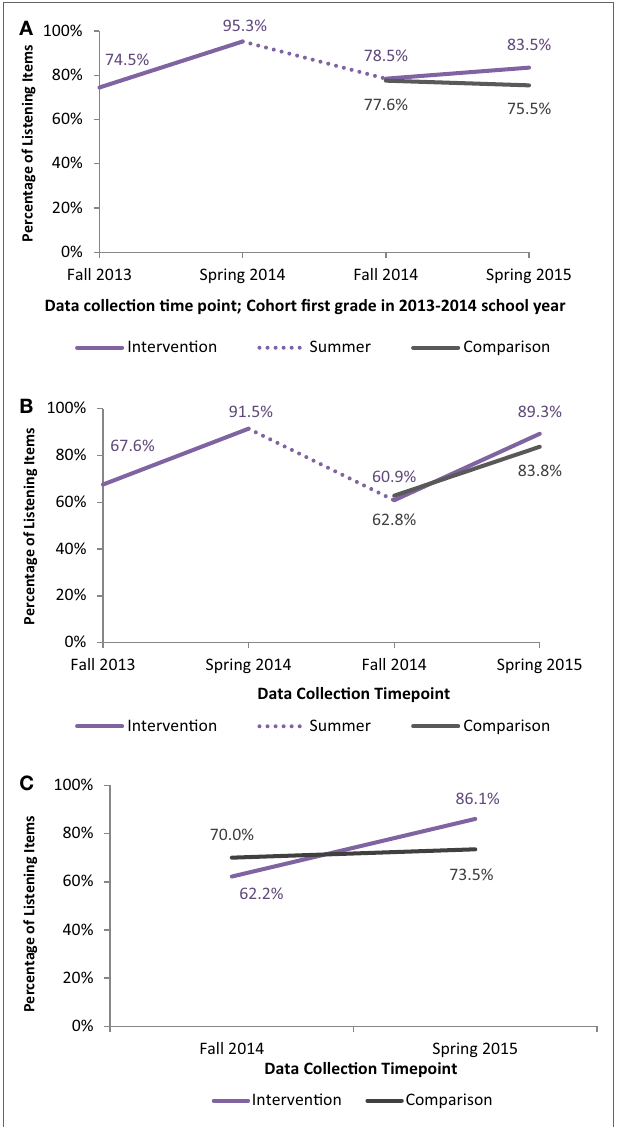
FigUre 2 | Mean percentage of listening comprehension at each time point by group and cohort, (a) cohort first grade in 2013-2014 school year, (B) cohort kindergarten in 2013-2014 school year, (c) cohort kindergarten in 2014-2015 school year.